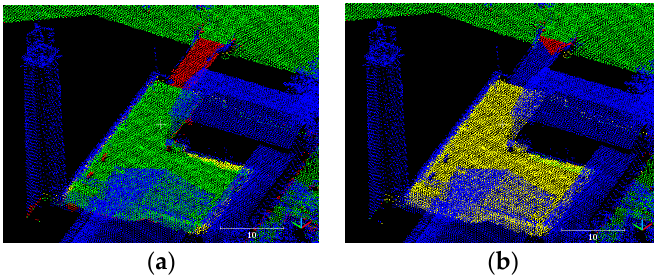
Figure 15. A situation when LAStools failed to detect a relatively flat ground surface: ( a ) FCN; ( b )